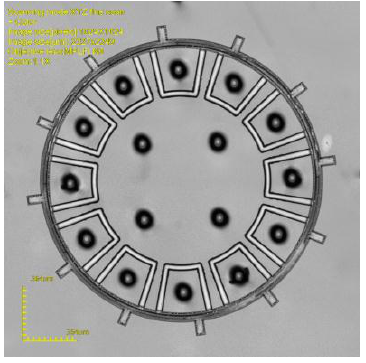
Figure 11. Picture of a ring gyroscope.